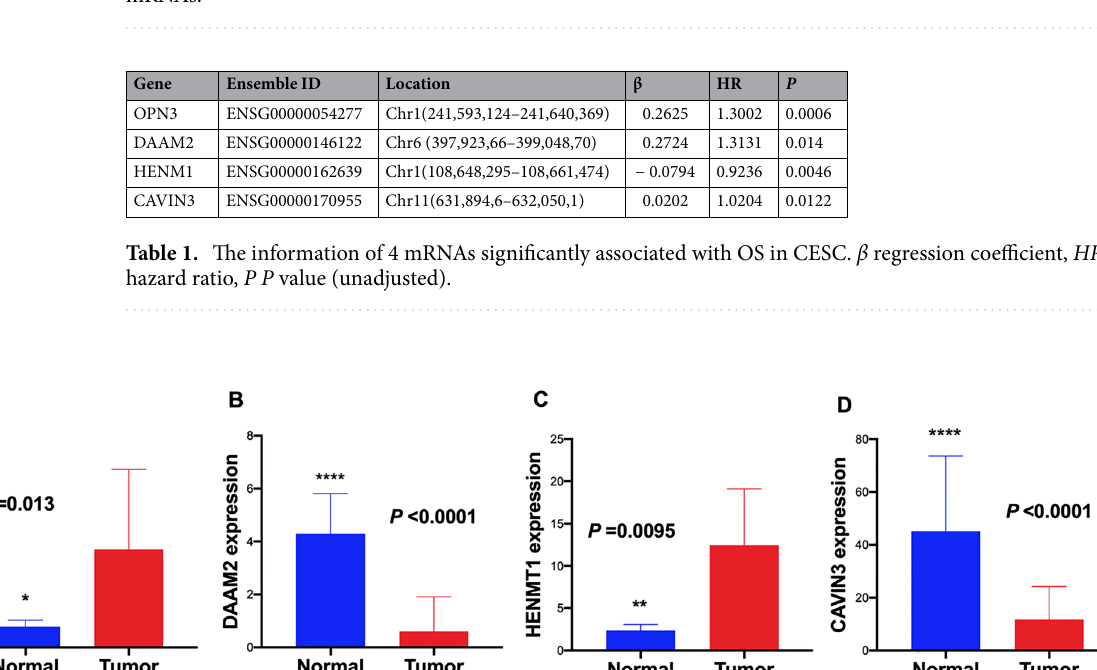
Figure 5. The prognostic ceRNA network in CESC. The connections indicate the interactions among lncRNAs, miRNAs, and mRNAs. The triangles represent miRNAs; the diamonds represent lncRNAs; the circles represent mRNAs.